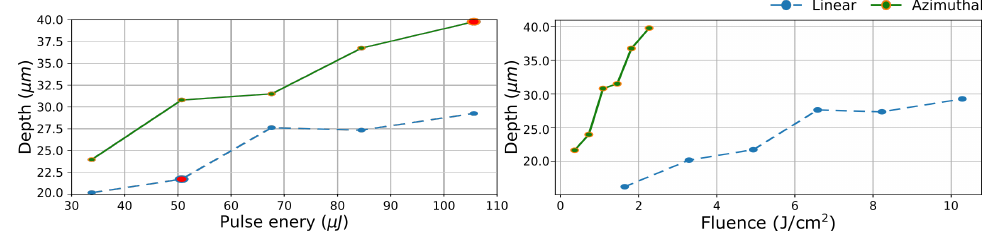
Figure 3. Depth variation as a function of the pulse energy ( right ) and fluence ( left ) of inscribed lines for Gaussian linear polarization and CV azimuthal polarization at 1 mm/s. Lines inscribed with linear polarization exhibit consistently lower depth than the ones inscribed with azimuthal polarization. The bold data points representing identical accumulated